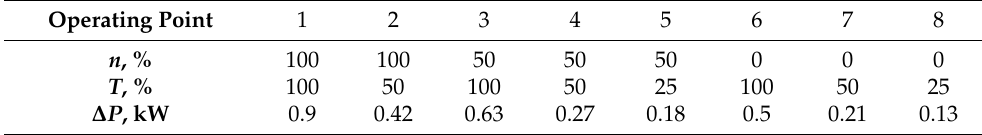
Table 5. Loss data for the 5.5 kW electric drive.